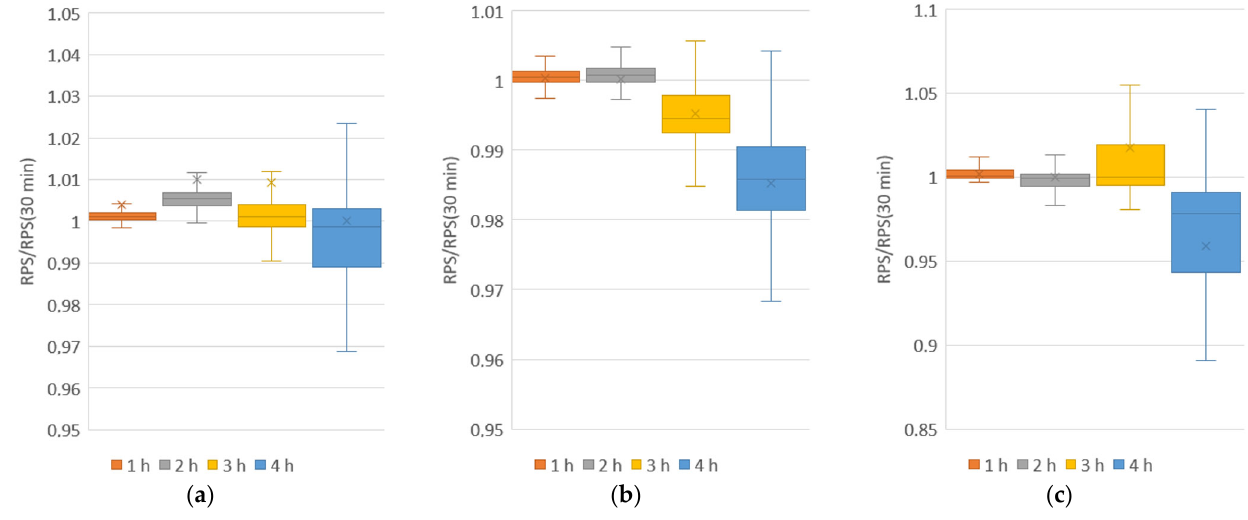
Figure 8. Diagrams of RPS for ( a ) 23005, ( b ) 39352 and ( c ) 47647 station ID’s. One ‐ year